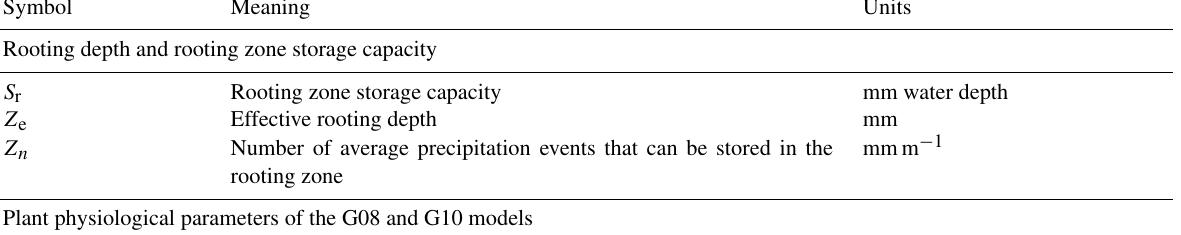
Table A1. List of all symbols used in this paper. The variables marked with an asterisk are the ones used in the sensitivity and uncertainty